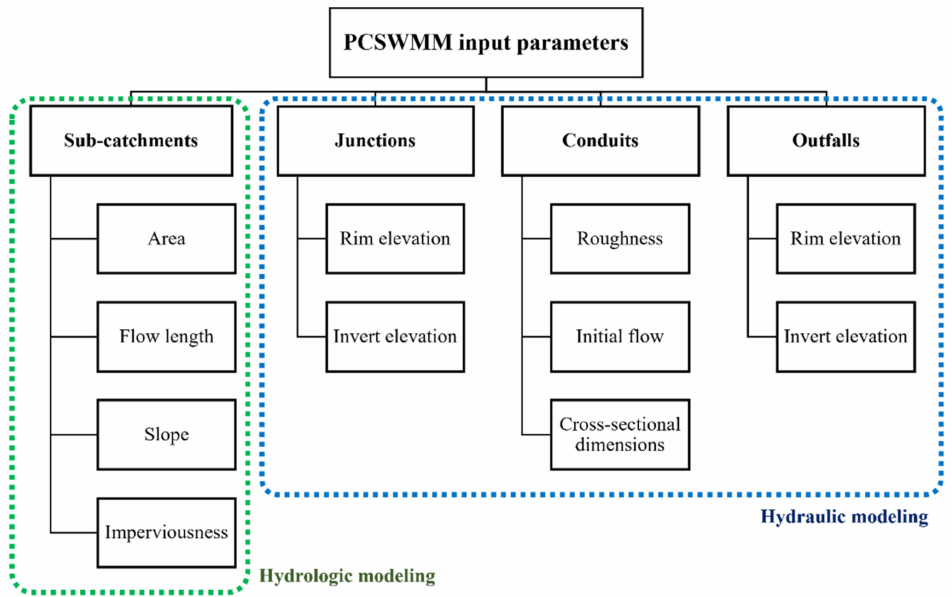
Figure 2. Input parameters used in PCSWMM for flood